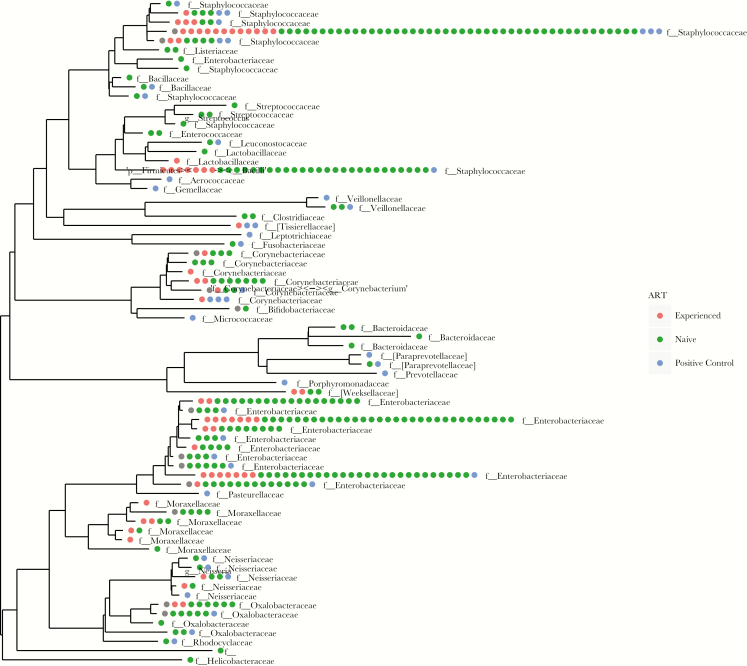
Results of next-generation sequencing. Positive controls are mock communities (Supplementary Materials). Phylogenetic tree, by antiretroviral therapy (ART) group (experienced or naive). Negative control operational taxonomic units (OTUs) were removed (rarefied), showing sparse OTUs, including Staphylococcaceae among other families. OTUs derived from both ART-experienced and ART-naive samples are distributed across the phylogenetic tree.